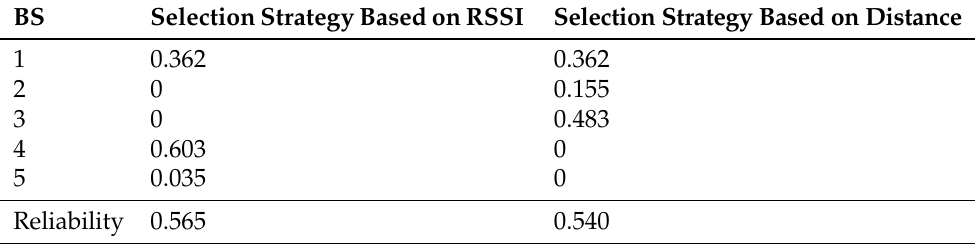
Table 6. Simulation results for reliability under given user distribution.